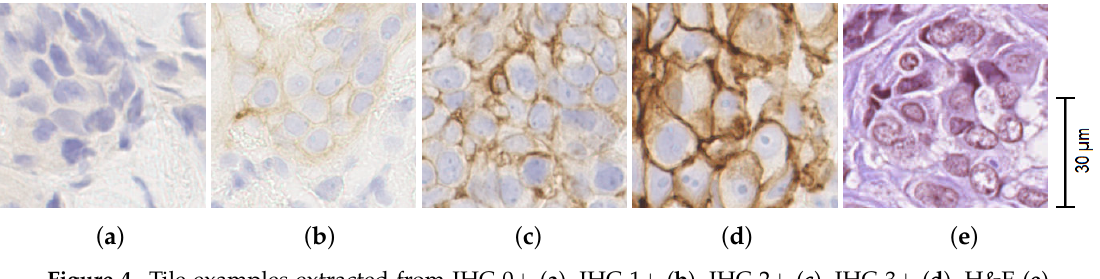
Figure 4. Tile examples extracted from IHC 0 + ( a ), IHC 1 + ( b ), IHC 2 + ( c ), IHC 3 + ( d ), H&E ( e ) slides. Tiles from IHC 2 + and 3 + and H&E slides were obtained by Otsu’s thresholding and the remaining were obtained by simply removing the pixels with background value. The IHC tiles